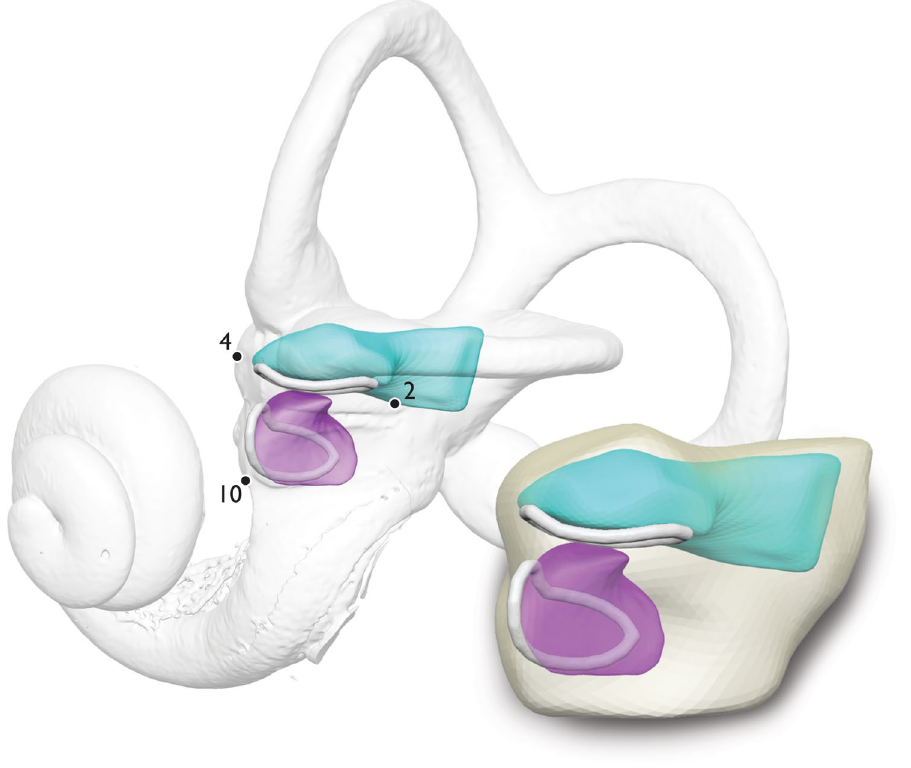
Figure 6. The morphometric model of the human otolith system. SPHARM-PDMs depict the mean bony vestibule (transparent light yellow), mean utricle (teal) and mean saccule (purple). SPHARM-PDMs are aligned using the consensus landmark configuration. Maculae contours (representing wireframes and shown here in white) are based on consensus semilandmark configurations. Numbers indicate important bony landmarks for estimating maculae configuration (for landmark descriptions see Supplementary Table 3). For a turntable video of this model see Supplementary Video